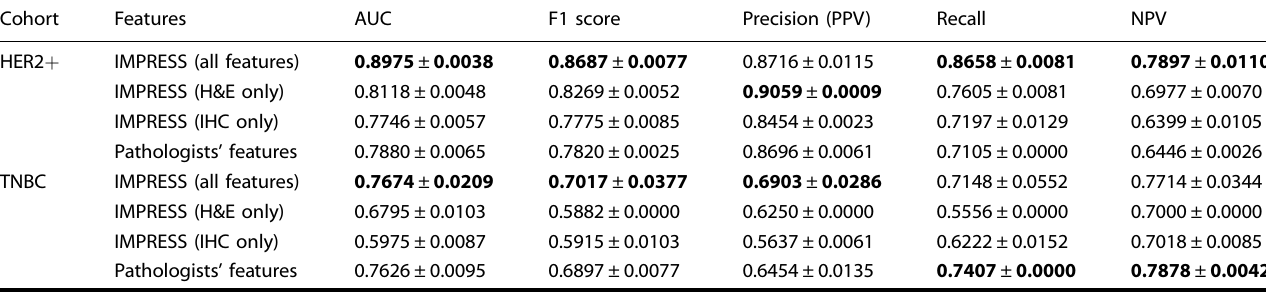
Table 2. LASSO-regularized logistic regression performances in HER2 + and TNBC cohorts.